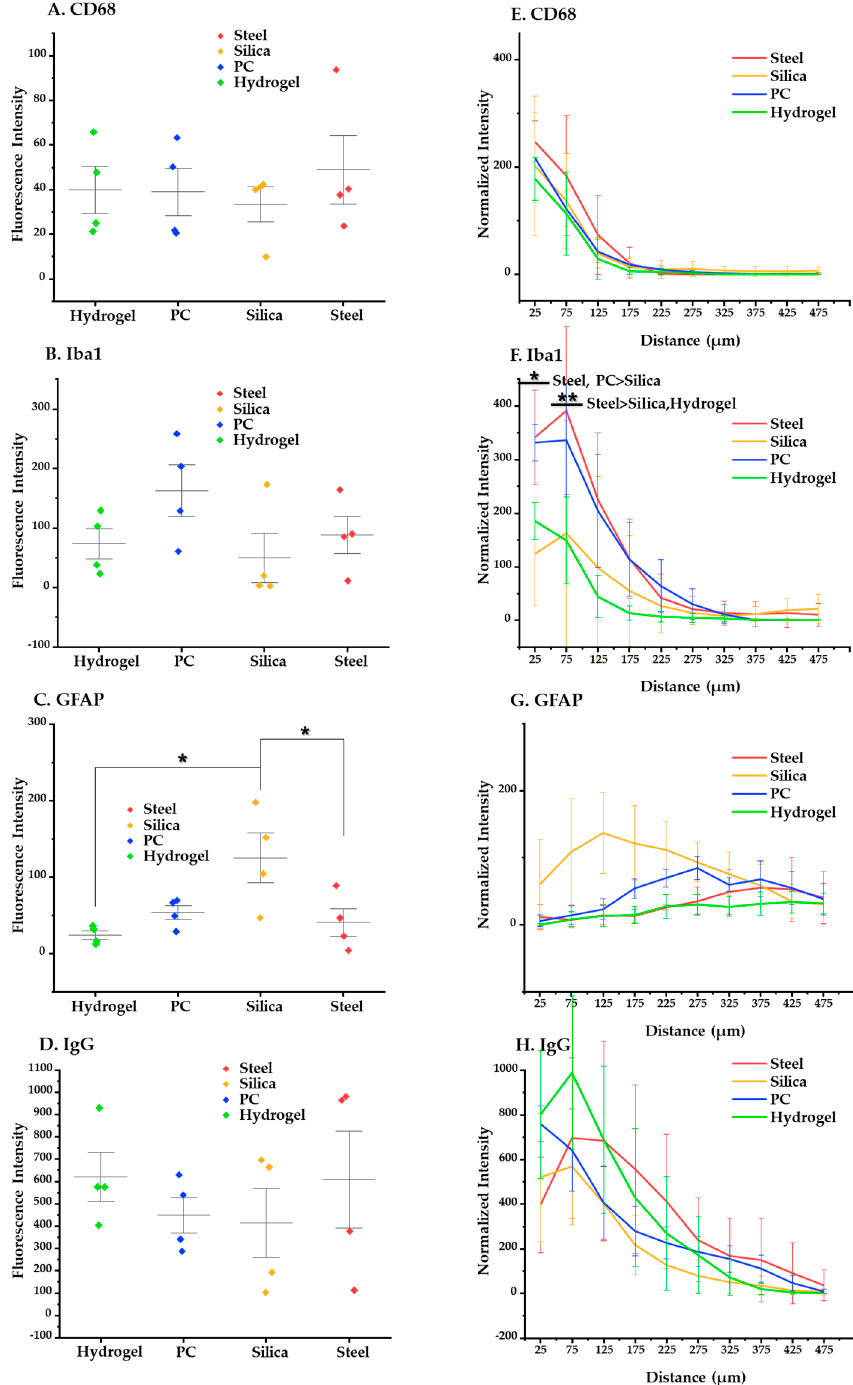
Figure 11. Statistical results about the acute (3 days) immune response. ( A – D ) Results of post-hoc Tukey’s test on one-way ANOVA with the mean values of intensity of each immune marker. ( A ) CD68, ( B ) Iba1, ( C ) GFAP, and ( D ) IgG. ( E – H ) Results of Tukey’s post-hoc test on two-way ANOVA based on distance, showing intensity profiles of each immune marker: ( E ) CD68; ( F ) Iba1; ( G ) GFAP; ( H ) IgG. The error bars represent the standard deviation. Significance: *: p < 0.05, **: p < 0.01.